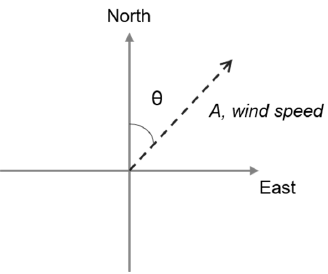
Figure 7. Kernel used to compute the vertical velocity 2b Schematic diagram for wind vector calculation.